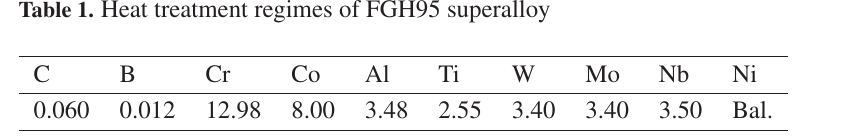
Table 1. Heat treatment regimes of FGH95 superalloy